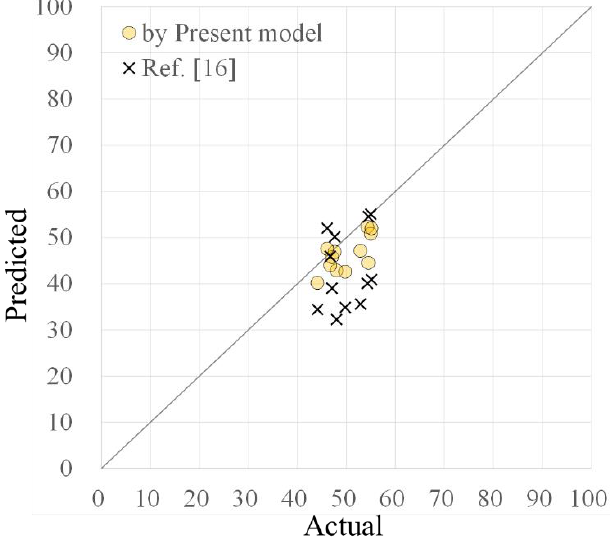
Figure 4. Comparison of predicted compressive strength with the actual strength of the 12 experimental concrete mixtures in [16] (Unit: MPa).